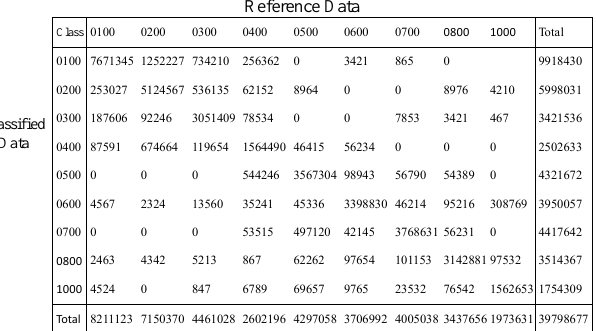
Table 3. Error matrix of sum of area of object samples